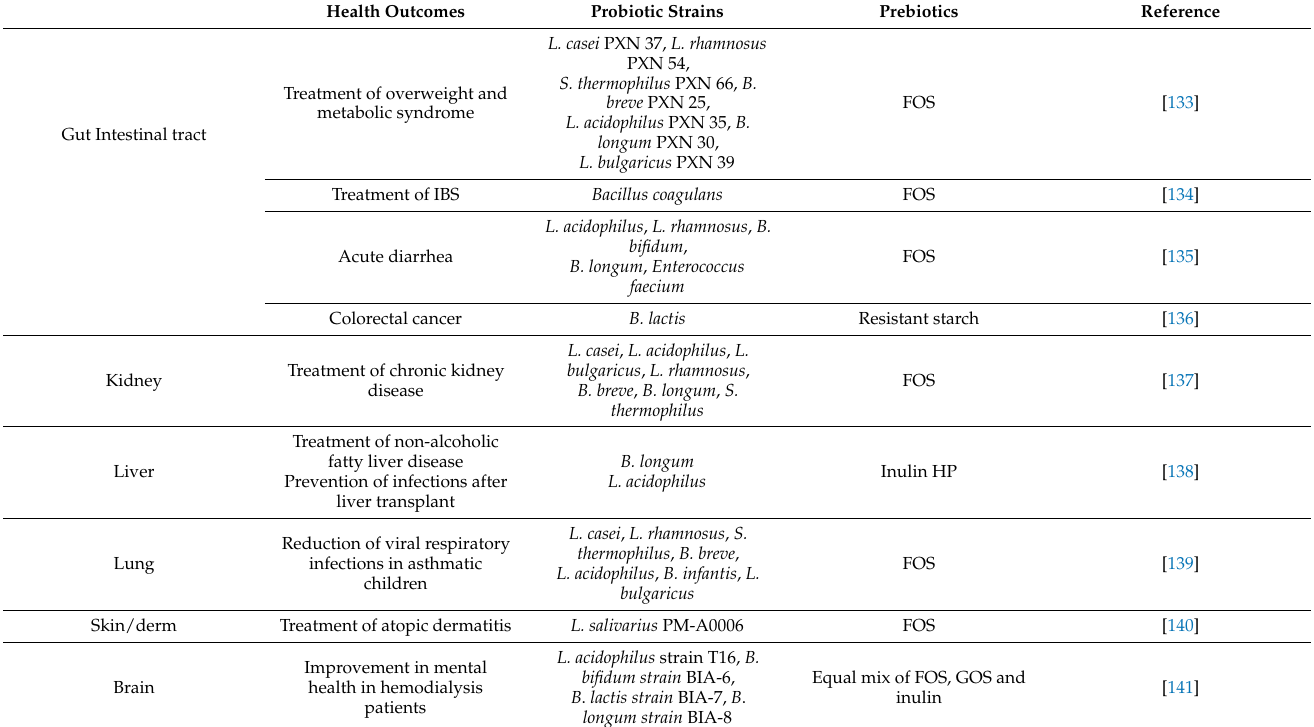
Figure 9. Illustration of action mechanisms of probiotics for promoting human health. GLP1: glucagon-like peptide 1, SCFAs: short-chain fatty acids, sIgA: soluble immunoglobulin A, TLR: toll-like receptor. Table 5. Example of human health benefits of synbiotics claimed from clinical